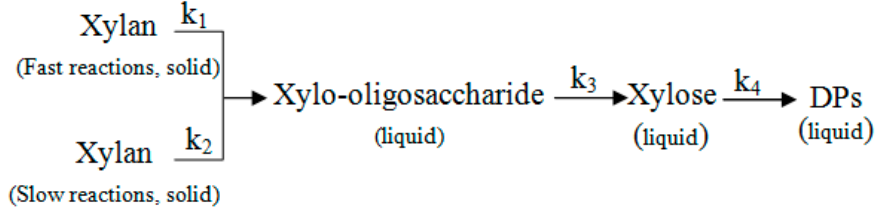
Scheme 3. The reaction process of xylan involved in the modified two-phase model.